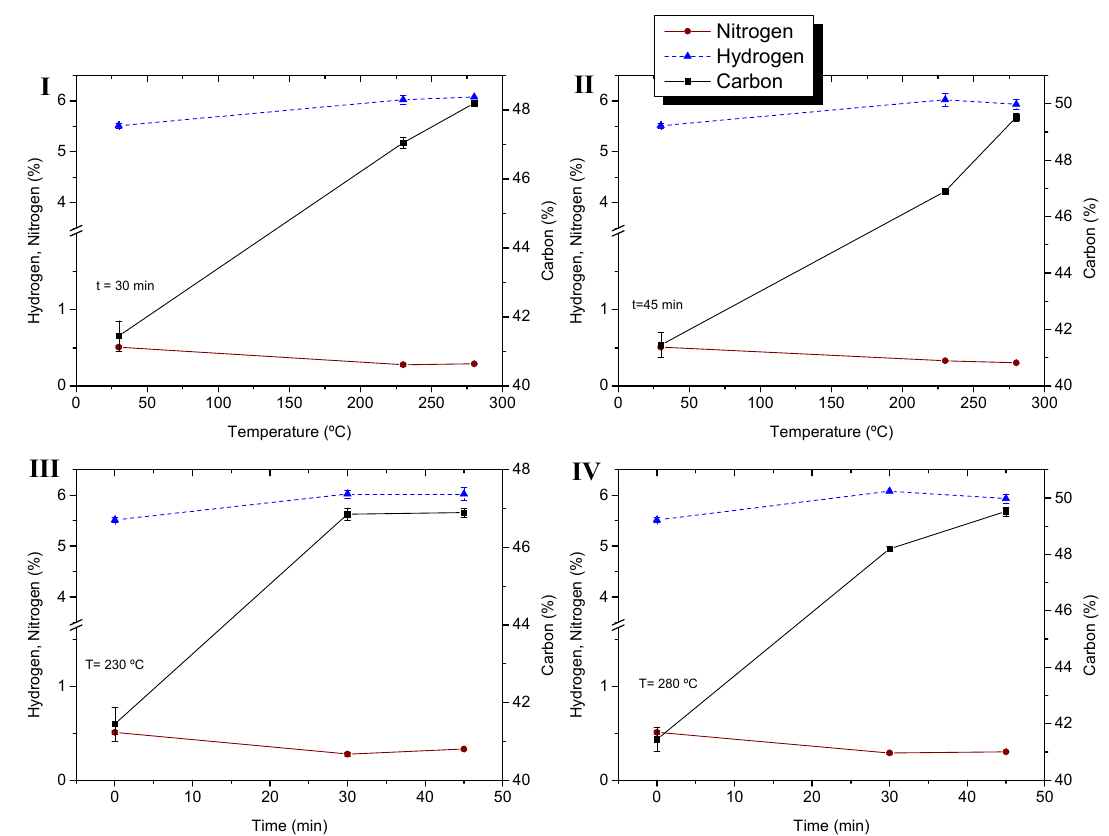
Figure 4. Effects of torrefaction temperatures ( I , II ) and residence times ( III , IV ) on the elemental composition of sugarcane bagasse.